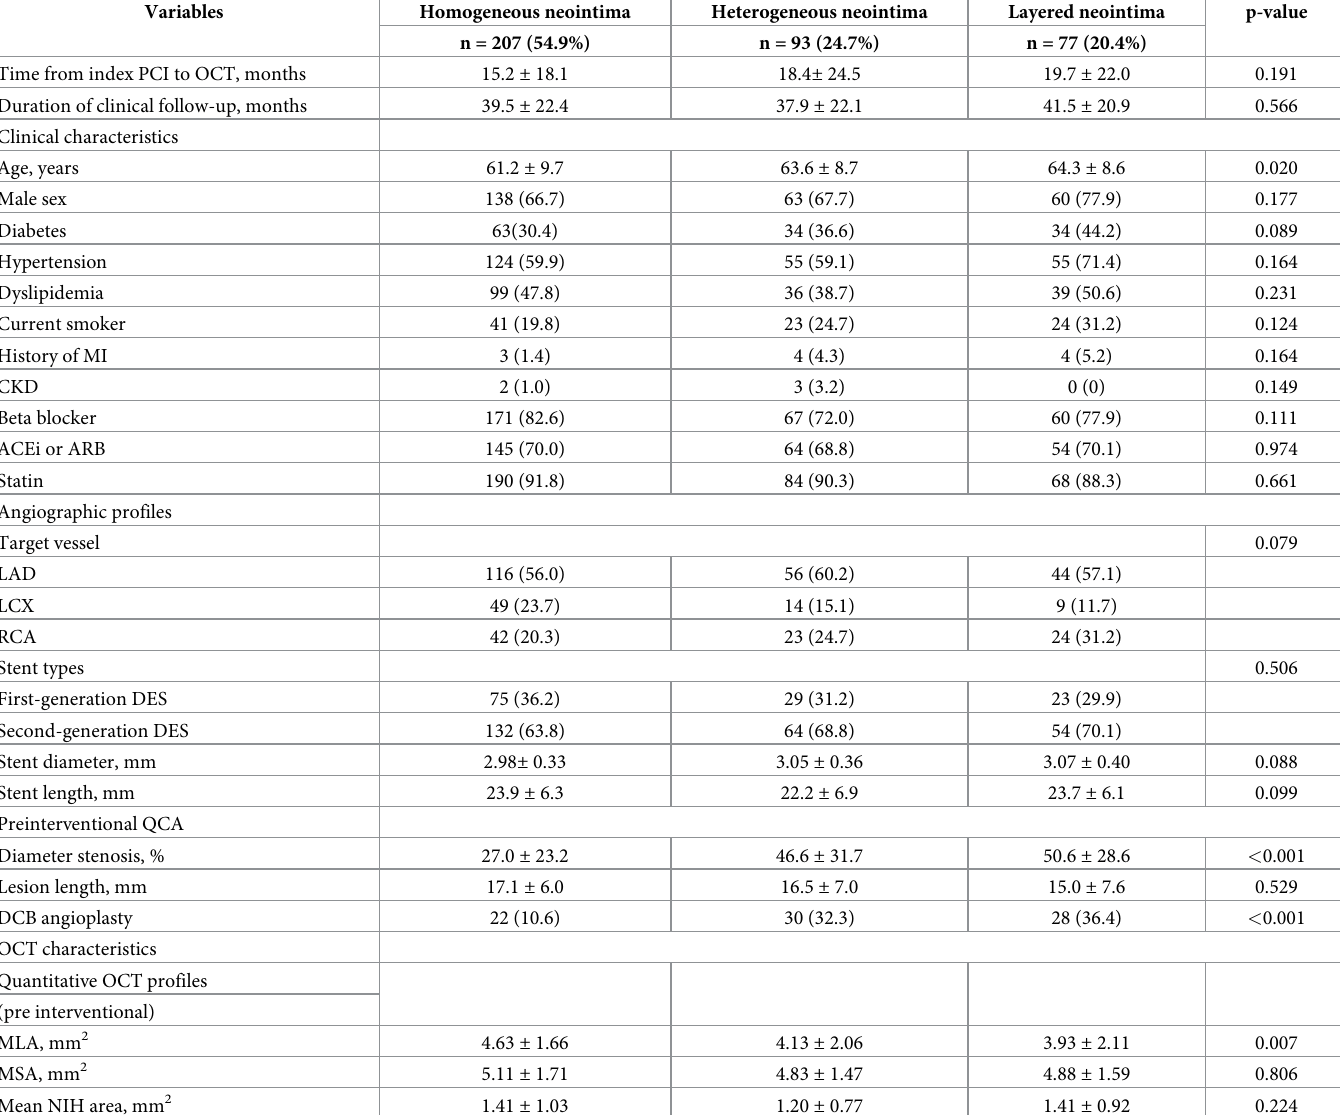
Table 1. Comparison of the baseline, angiographic, and OCT characteristics according to the neointimal characteristics.